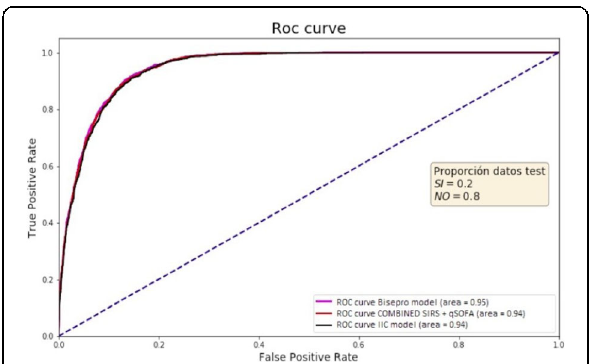
Fig. 1 (abstract 001142). See text for